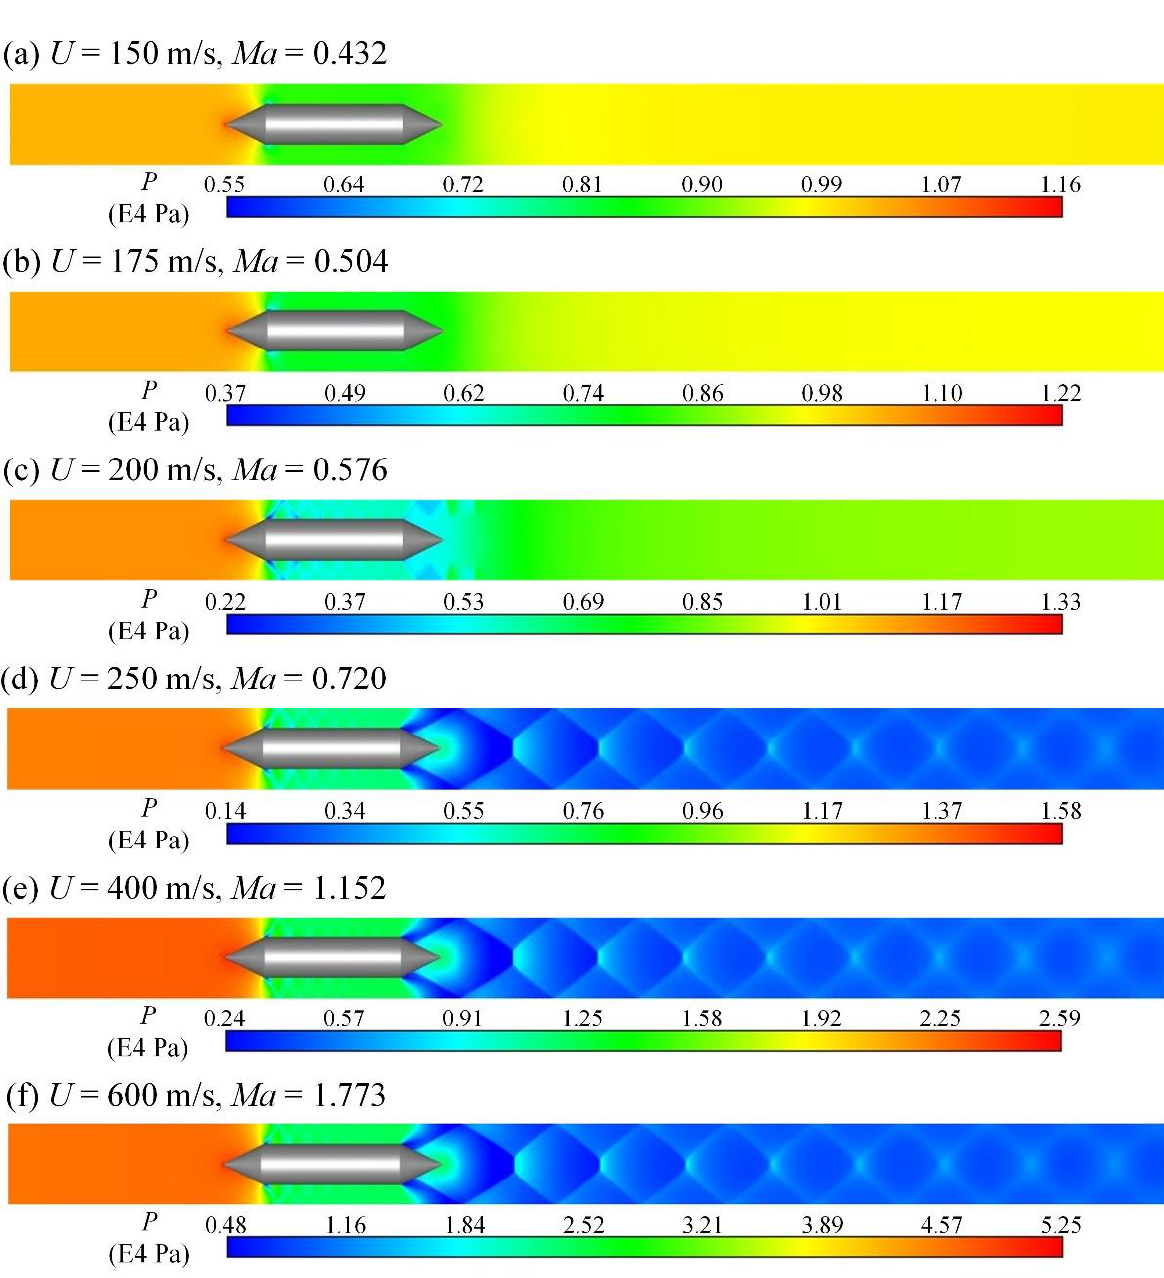
Figure 13. Pressure contours in the ( x, z ) plane at y = 0.